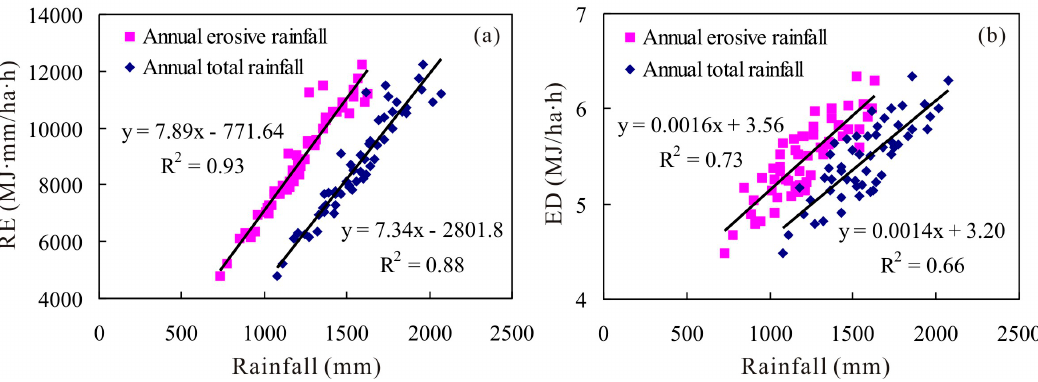
Figure 10. Scatter plots of precipitation and ( a ) annual rainfall erosivity and ( b ) erosivity density.